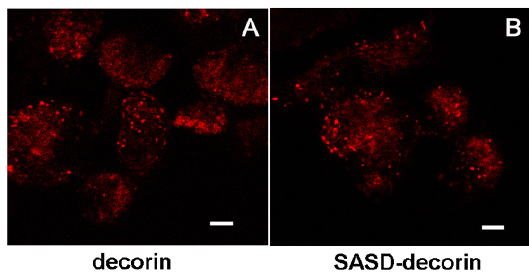
FIGURE 3. Uptake of SASD-conjugated biotinylated decorin by human skin fibroblasts. Decorin purified by HPLC- DEAE was biotinylated and conjugated to SASD as described above. Human skin fibroblasts were incubated at 37°C for 10 min with 5.2 µg/ml of btn-DCN (A) or btn-DCN-SASD (B) in endocytosis medium, followed by incubation for a chase period of 10 min with ligand-free medium. Cells were trypsinized and stained for biotinylated decorin using Alexa555-